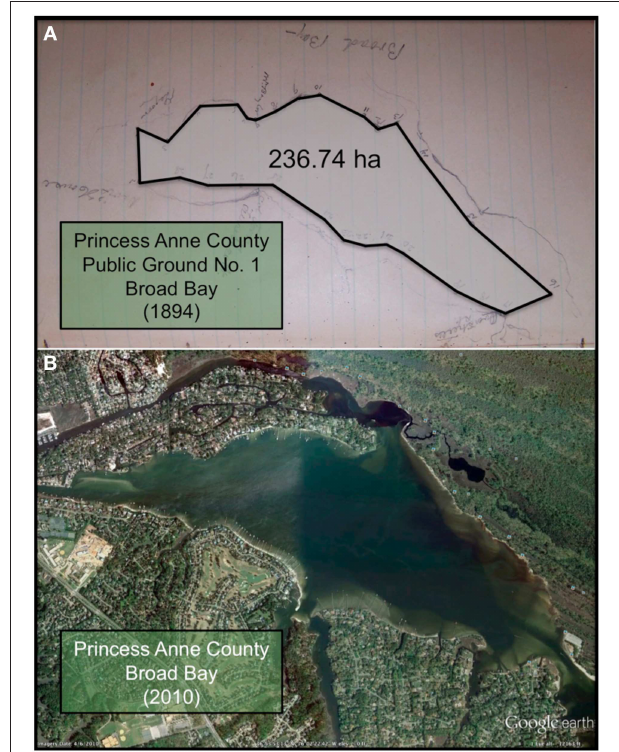
FIGURE 3 | (A) Photograph of the sketch by Baylor (1893) for Public Ground No. 1 (Broad Bay) in Princess Anne County, with a polygon connecting the points of the oyster ground superimposed on the photograph. The shoreline of Broad Bay is faintly visible bordering the polygon. (B) Recent satellite image of Broad Bay, at approximately the same scale as the sketch, adapted from Google